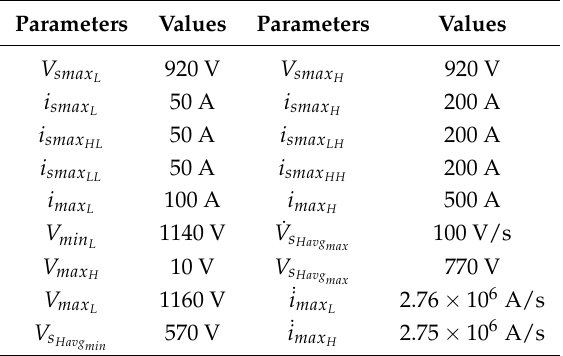
Table 1. Operating boundaries.